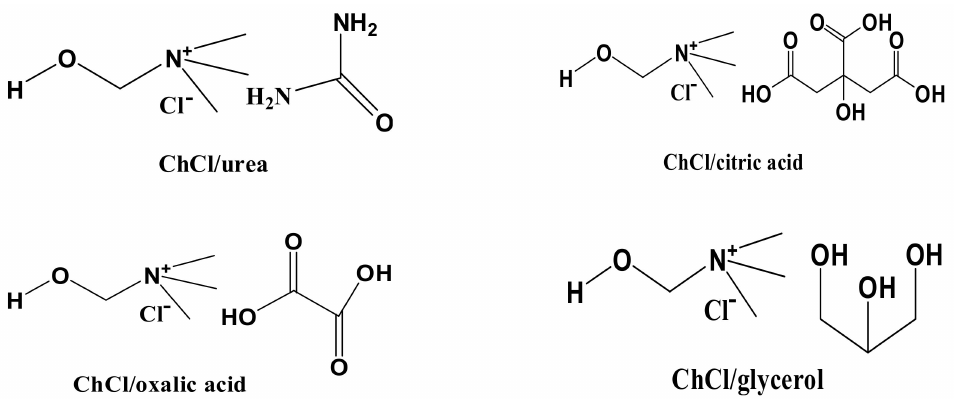
Figure 7. The structure of the four choline-chloride-based DESs.